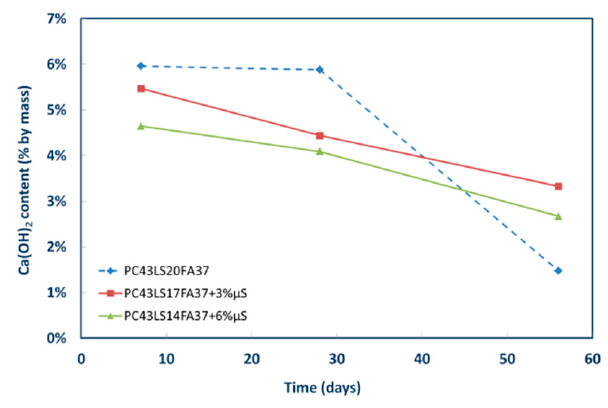
Figure 21. Ca(OH) 2 content μ S modified cementitious matrices based on PC43LS20FA37.